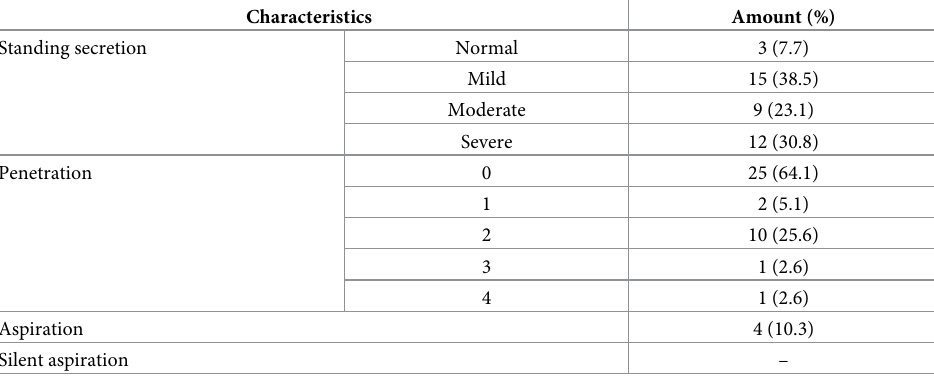
Table 3. Swallowing assessment with FEES.